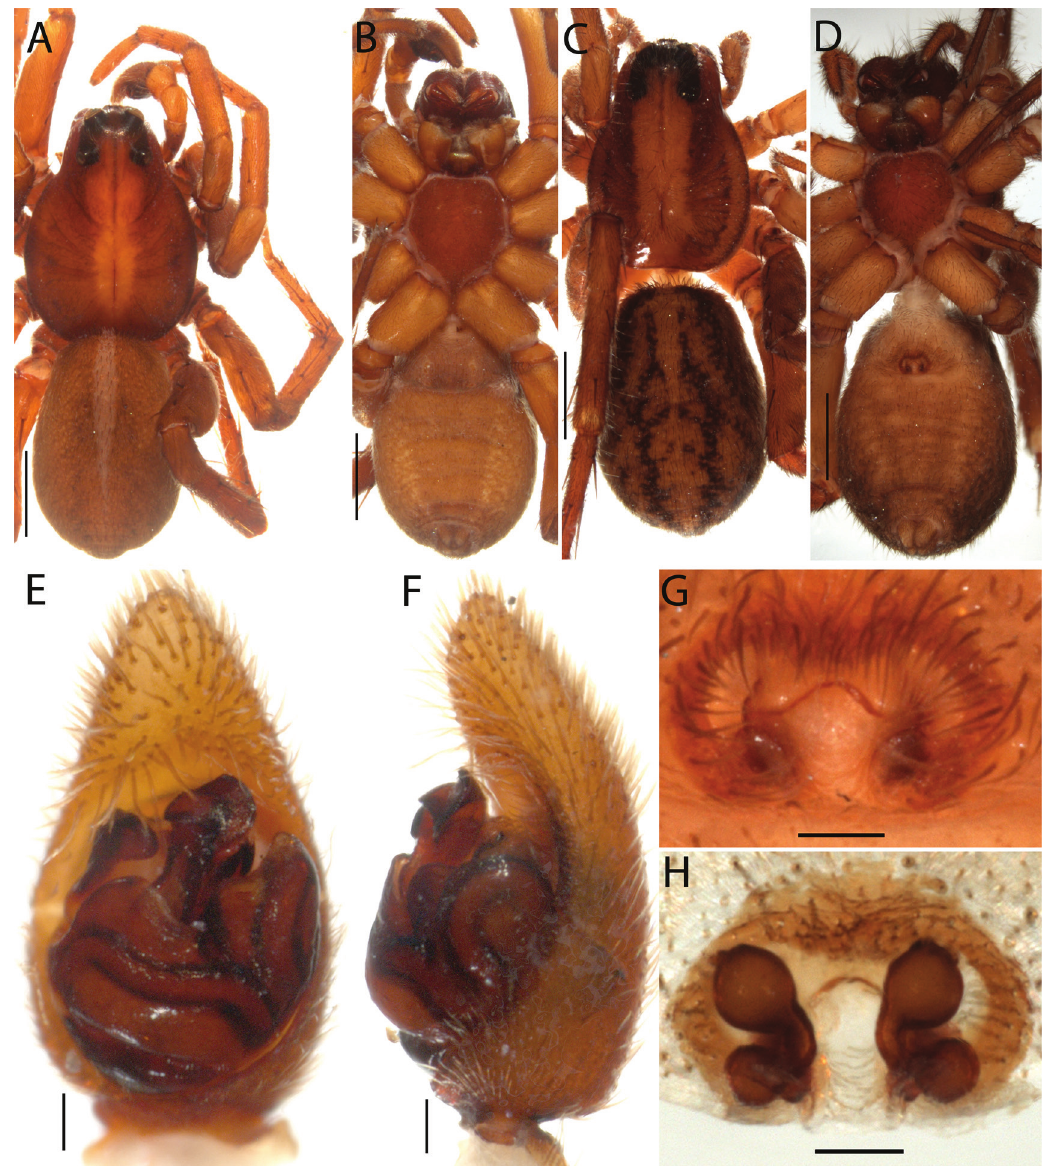
Figure 5. Artoria alta (Framenau, 2004) male (AM KS44789), female (AM KS 27957): A , male habitus, dorsal view; B , male hab- itus, ventral view; C , female habitus, dorsal view; D , female habitus ventral view; E, male pedipalp, ventral view; F , male pedipalp, retrolateral view; G , epigyne, ventral view; H , epigyne, dorsal view. Scale bars: habitus 1.0 mm; pedipalp, epigyne 0.1